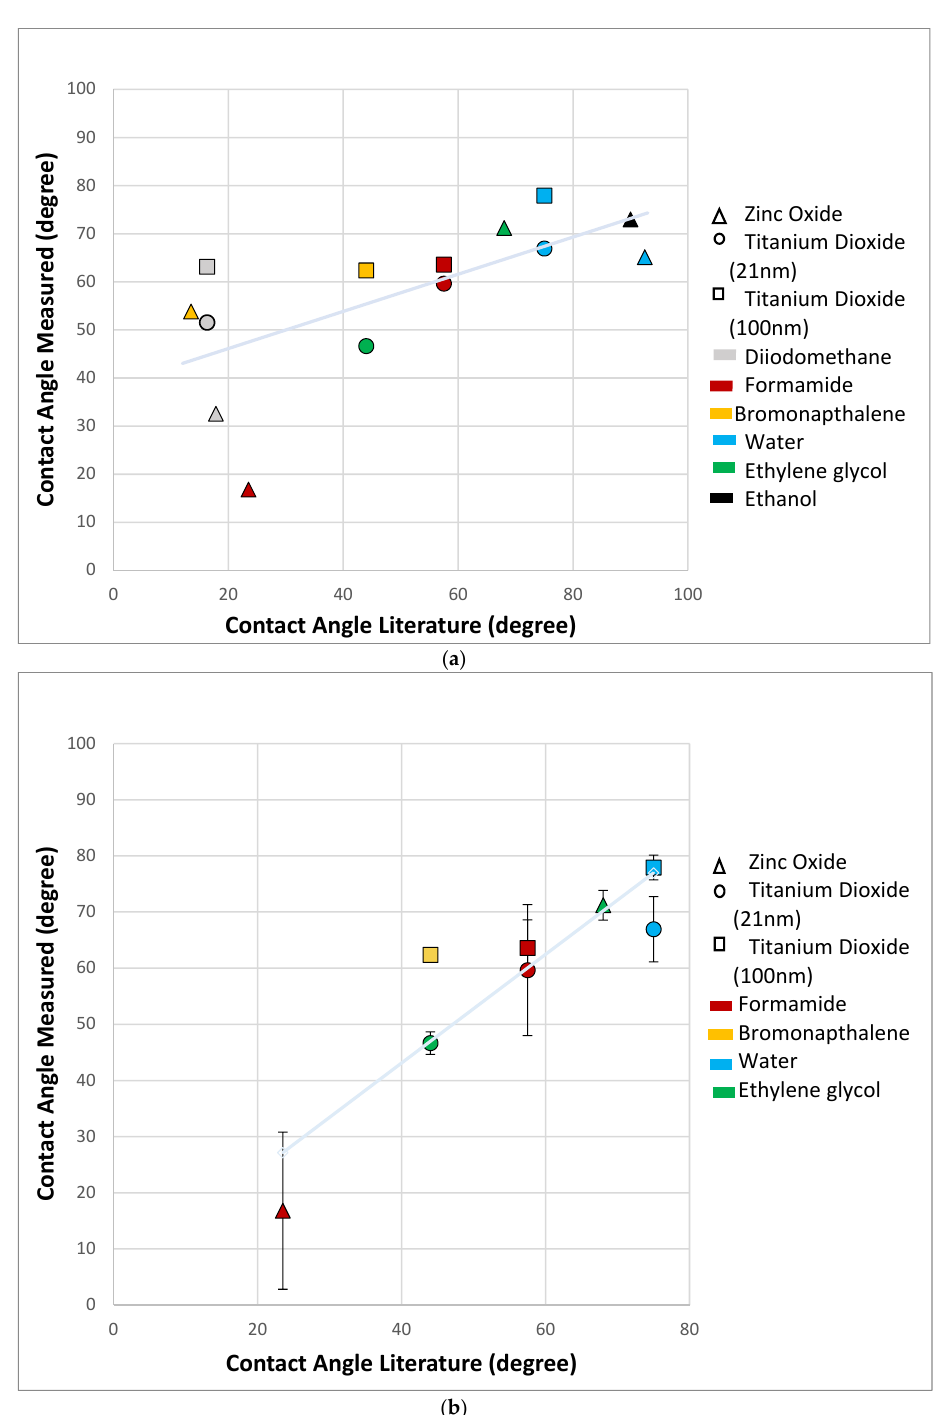
Figure 4. ( a ) Experimental contact angle versus literature contact angle based on substrate and solvent. A linear relationship can be seen in the data with the exception of points at low contact angles. The correlation value is 0.44 with a slope of 0.39 shown by the linear regression (light blue line). Symbol shape represents the nanoparticle tested and color indicates the solvent for the data point. ( b ) Experimental contact angle versus literature contact angle with elimination of data > 90 degrees and diiodomethane. A clear linear relationship can be seen giving a correlation value of 0.82 and a slope of 0.97 shown by the linear regression (light blue line). The literature values are an average of the contact angle values using di ff erent measurement methods on a variety of surface